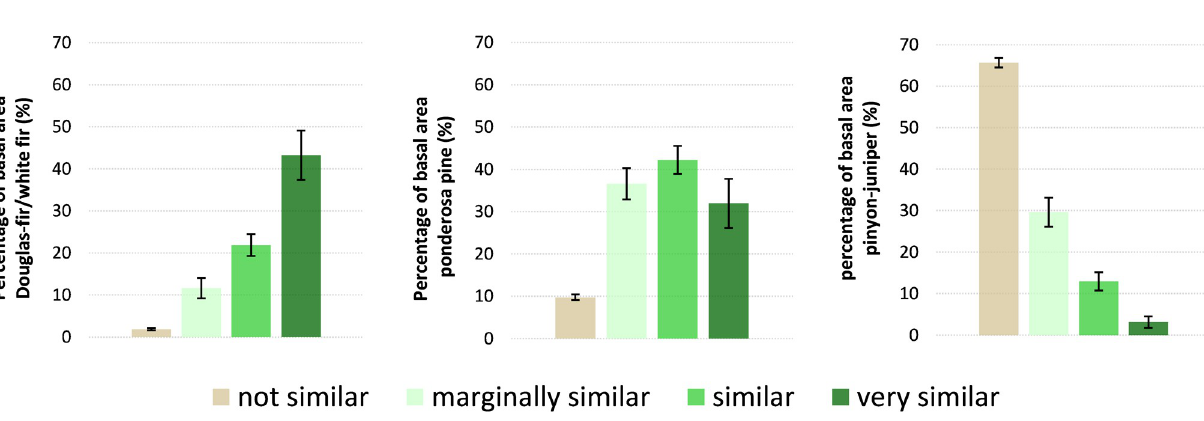
PLOS ONE | https://doi.org/10.1371/journal.pone.0265175 March 17,